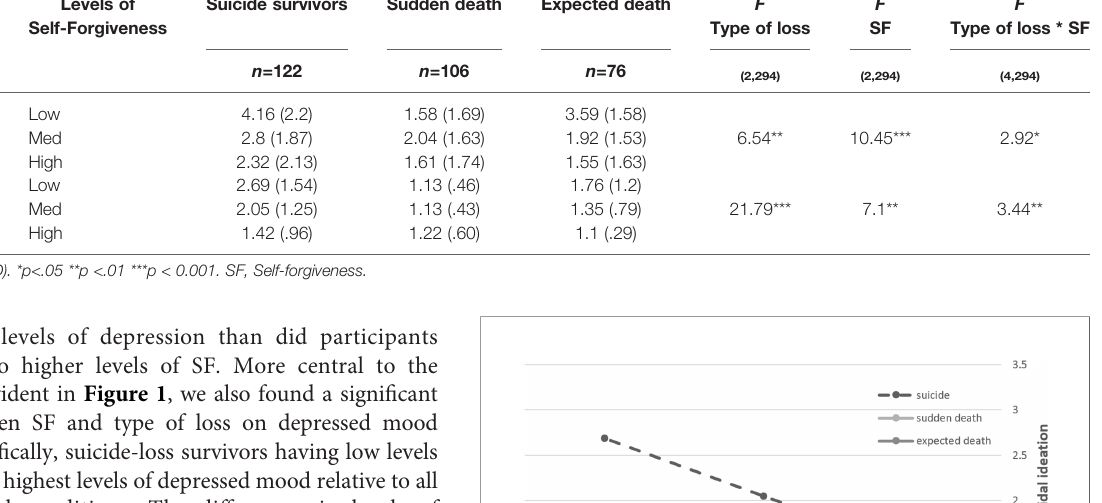
TABLE 2 | Means, standard deviations, and MANCOVA results of depression and suicidal ideation among the groups (N=309). Dependent variable